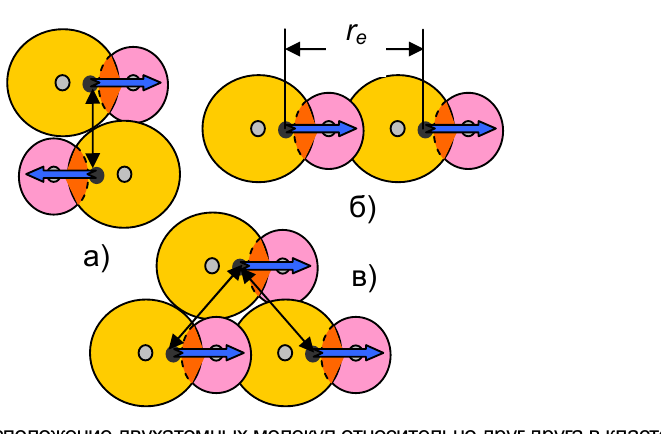
Figure 2 – Different positions of diatomic molecules in the cluster: а ) antiparallel b) linear c)